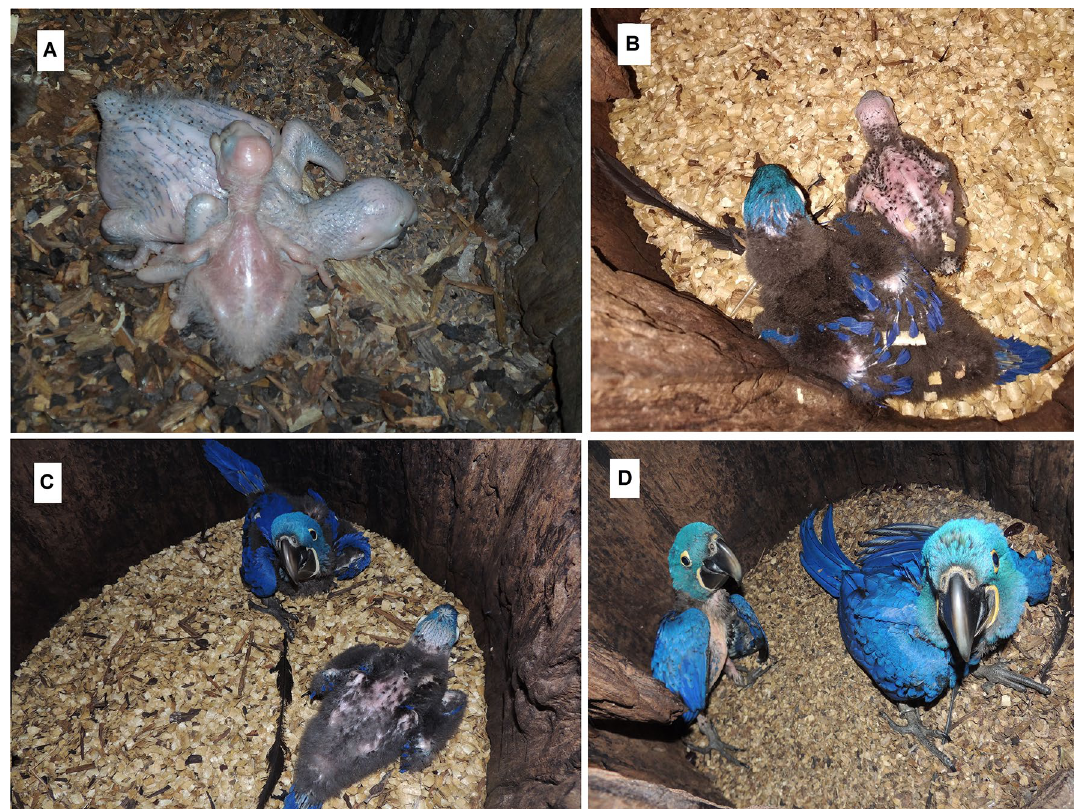
Figure 3. Development phases of the chicks: ( A ) nestling, 0–25 days, birds on picture are 17 and 18 days, respectively. Mass gain at this phase is slow, ( B ) chick, 26–77 days, birds on picture are 44 and 45 days, respectively, ( C ) chicks, birds on picture are 61 and 62 days, respectively. Geometric growth until maximum weight is attained, ( D ) juvenile, 78–107 days, birds on pictures are 104 and 105 days, respectively. Weight is maintained up to 90–95 days when weight loss begins with the first attempts of flying.